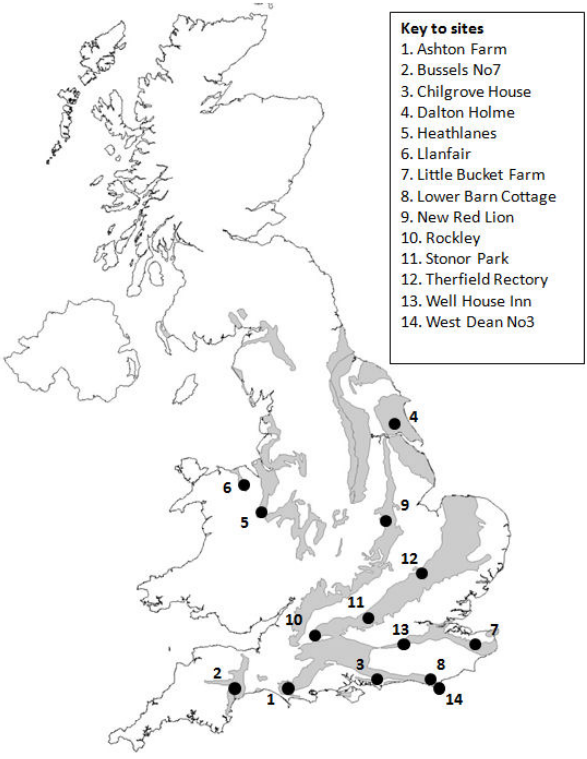
Fig. 1. Location of the observation boreholes in relation to the major aquifers in the